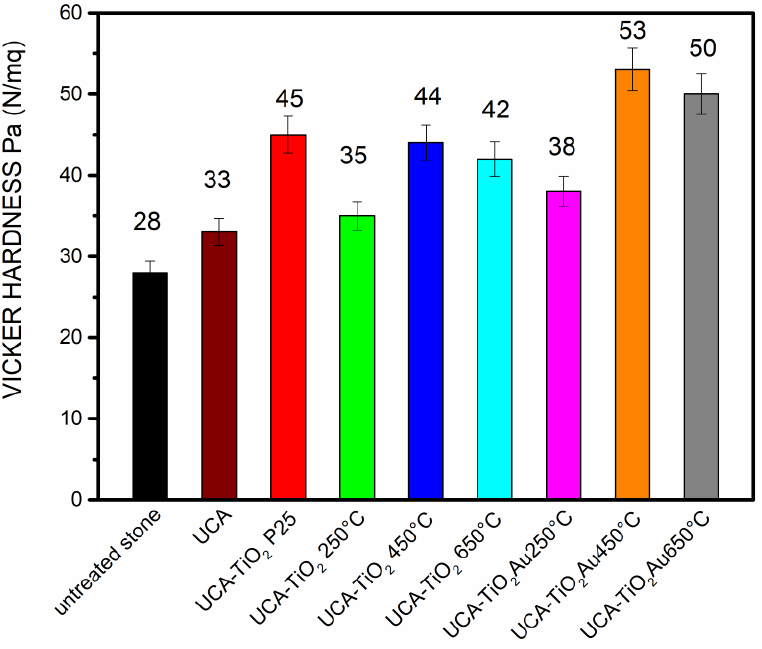
Figure 5. Histogram of mechanical resistance obtained by Vicker test, for the limestone under study after the application of our photocatalyst. Table 3. Determination of water absorption coefficient (WAC), relative capillary index (RCI) and